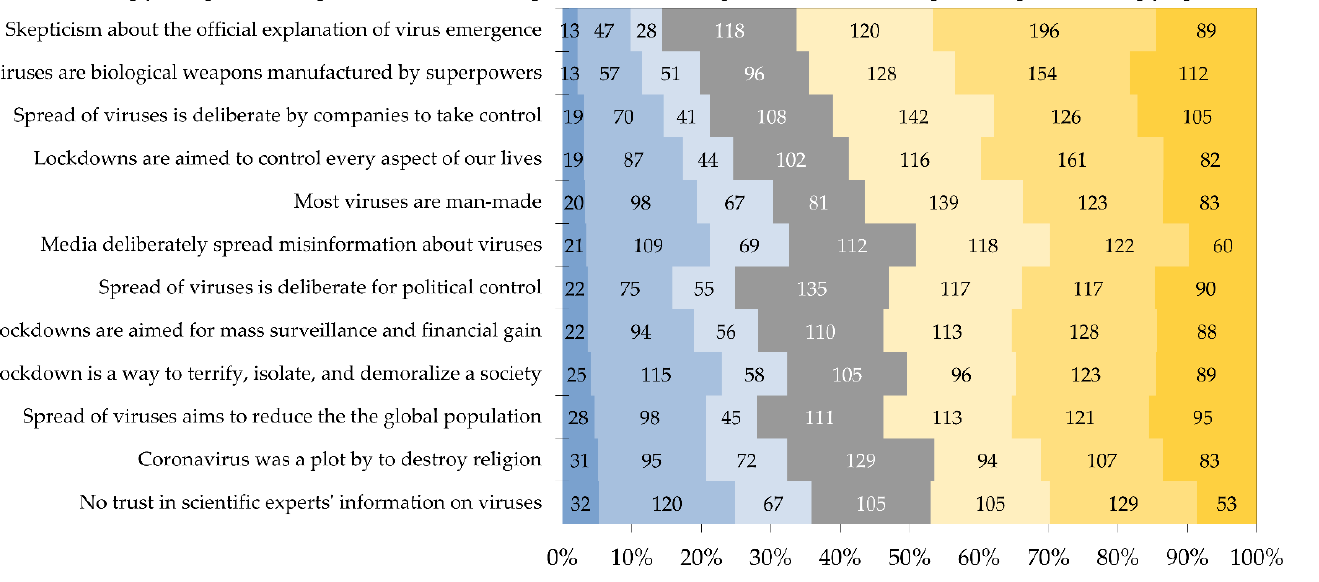
Figure 1. Conspiratorial attitude of the study participants towards emerging virus infections and its subsequent measures.